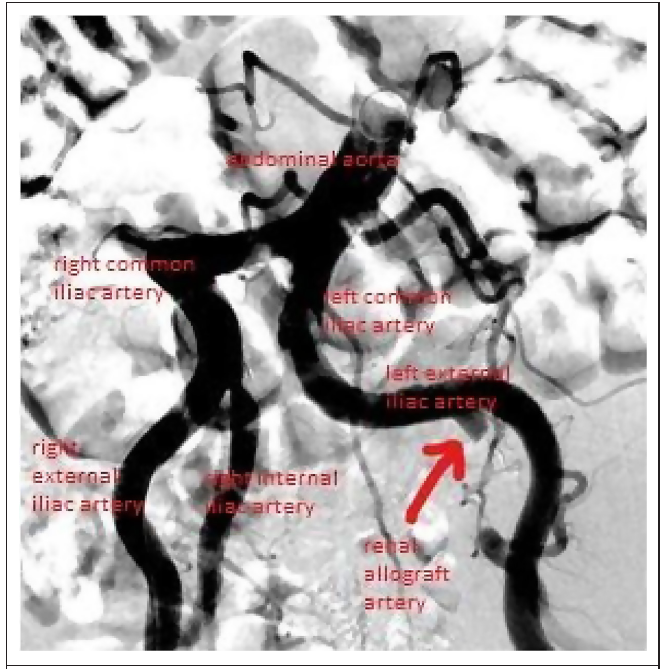
Figure 1. Blunt outcome (thromboembolism) of the anastome of the transplanted kidney to the iliac artery in renal